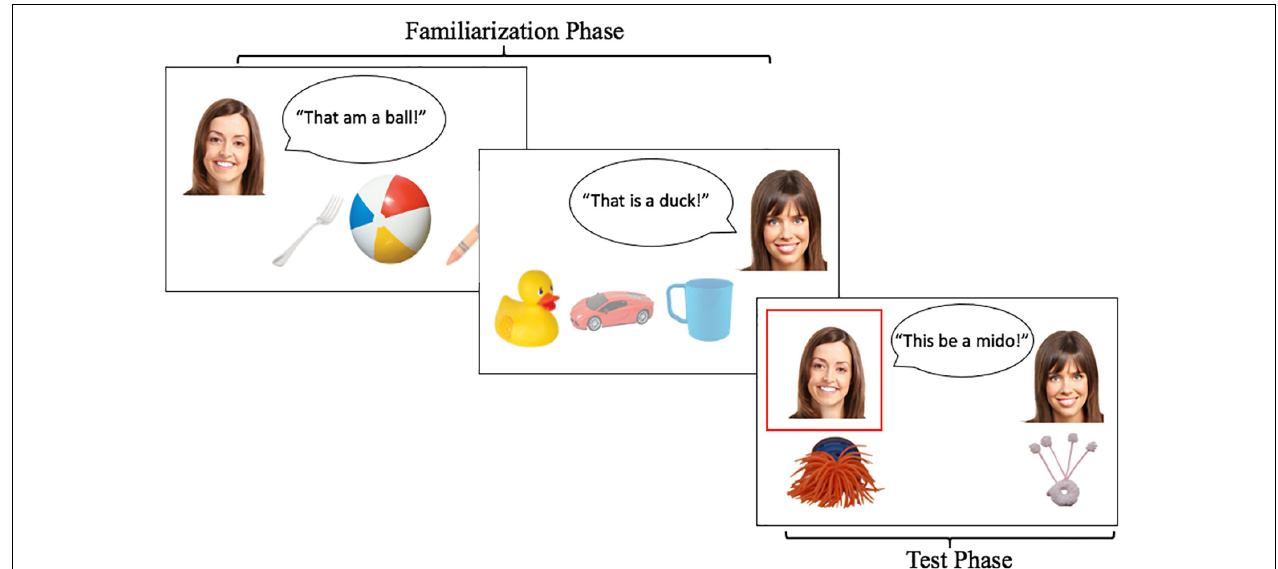
FIGURE 1 | Example of familiarization and test phase of one trial of Experiment 1. Children first saw each informant label a set of familiar objects. This was followed by the test phase, in which each informant used a label to describe a novel object. A red box appeared around each informant as her test utterance played (Photo 13942088 / Smiles © Kurhan | Dreamstime.com).